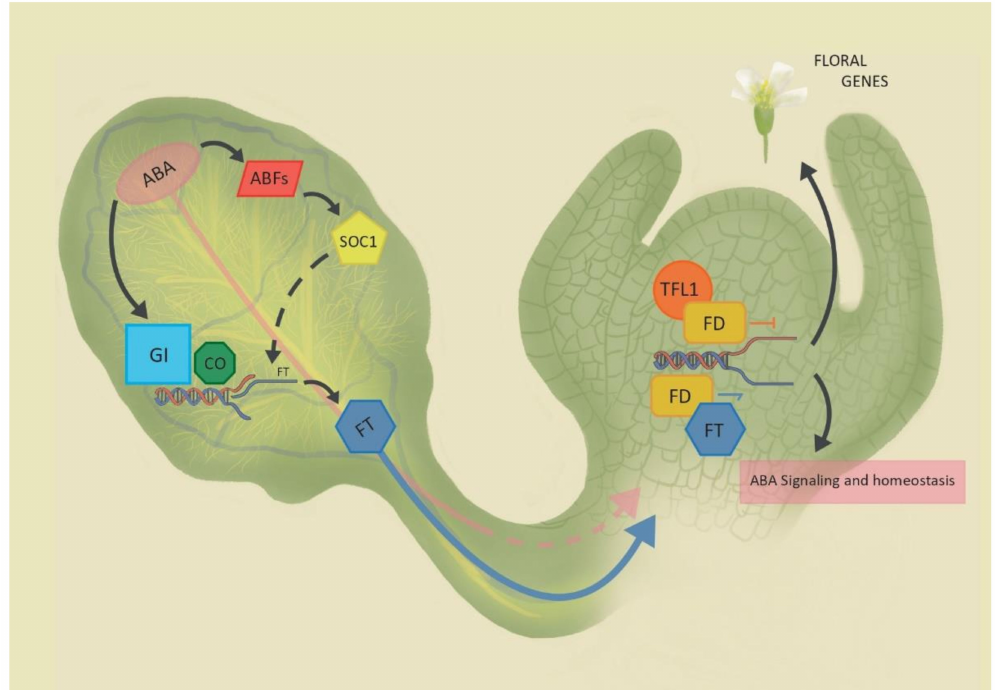
Figure 1. Abscisic acid (ABA) signaling and flowering regulation. In the leaves (left), ABA controls FLOWERING LOCUS T (FT) transcription acting on GIGANTEA (GI) and CONSTANS (CO); ABA-responsive transcription factors (ABFs) can modulate SUPPRESSOR OF OVEREXPRESSION OF CONSTANS 1 (SOC1) expression, in turn a ff ecting FT transcription through an indirect mechanism. FT moves to the SAM where it interacts with FD and FD-like basic leucine zippers (bZIPs) to activate floral genes and ABA signaling transcriptome. ABA is transported in the phloem, but its roles at the SAM are not yet known. TERMINAL FLOWER 1 (TFL1) antagonizes FT, repressing transcription. Dashed lines represent indirect or not yet confirmed pathways, while full lines represent known